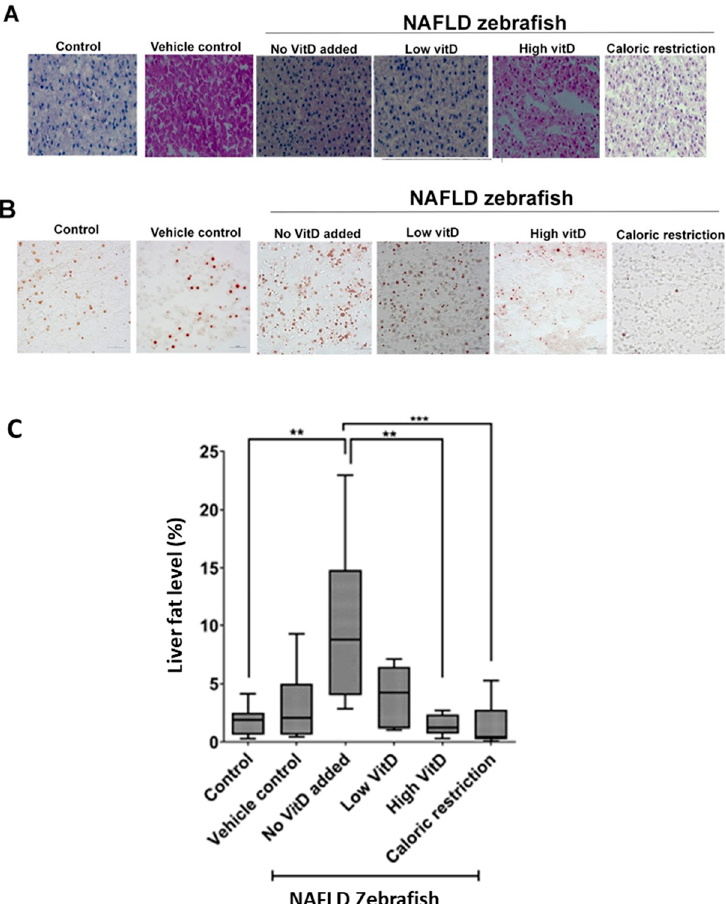
Figure 2. Liver morphology and fat level in NAFLD zebrafish supplemented with VitD.